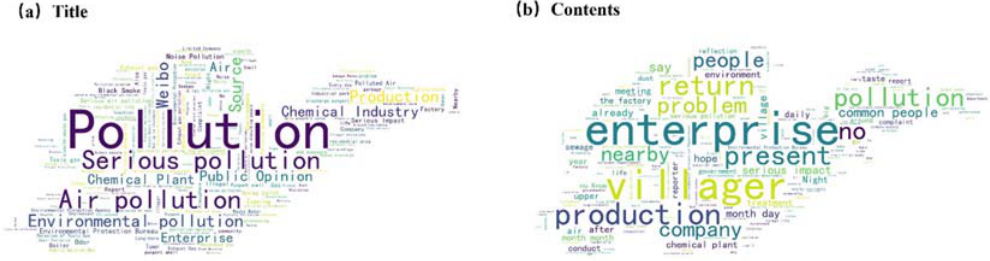
Figure 8. Word cloud analysis of the title ( a ) and content ( b ) of Shandong public complaint data.